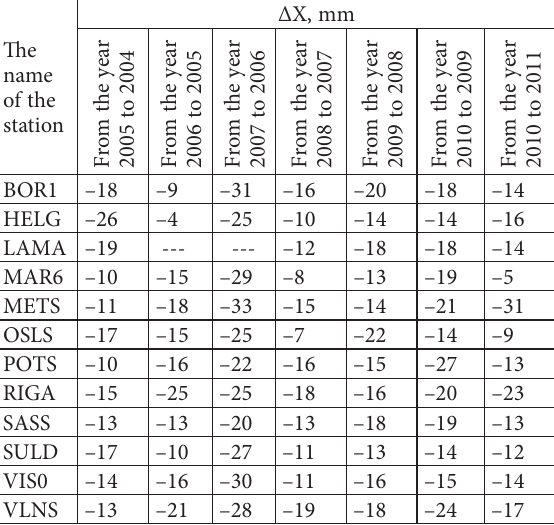
Table 1. The displacements of geocentric coordinate X of the